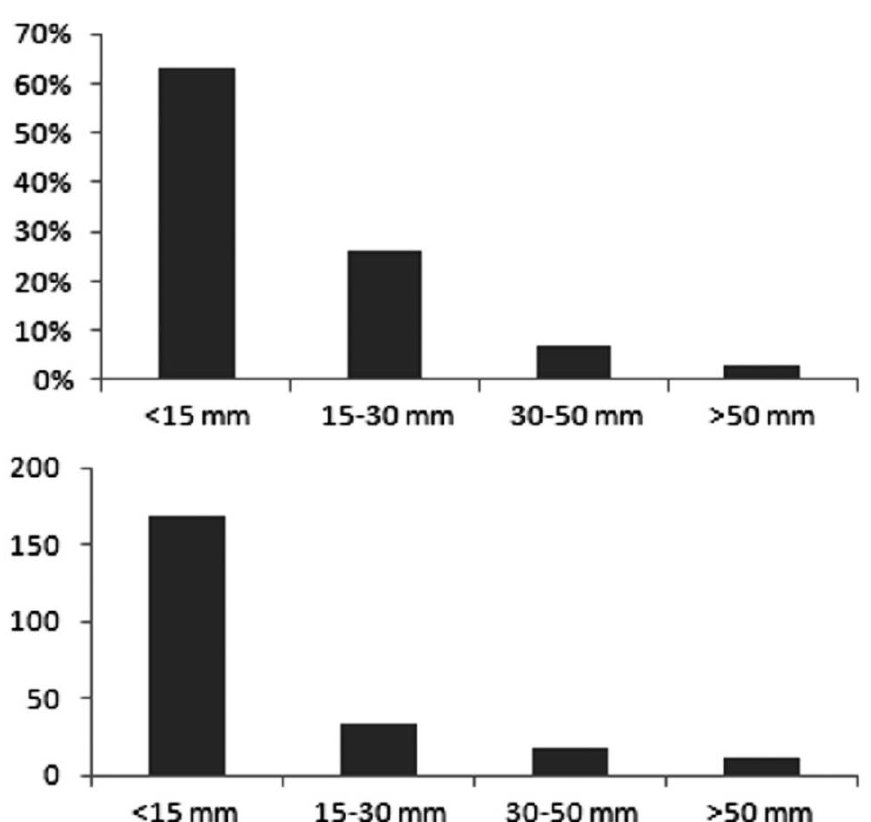
Figure 22. Size distribution of experimental (top) and archaeological (bottom)